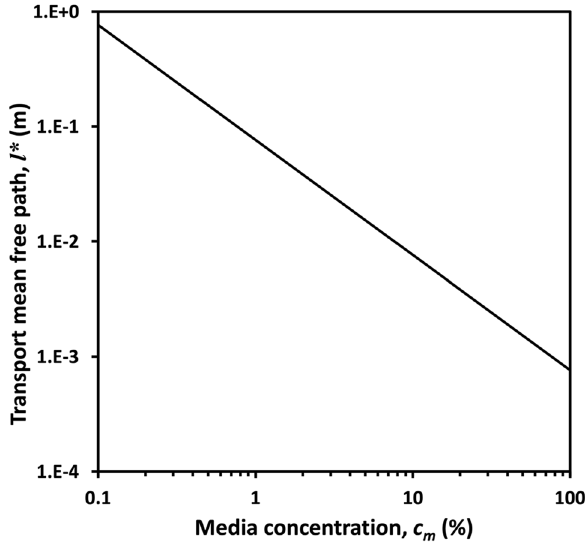
Figure 3. The variation between transport mean free path and media concentration from 0.1 to 100%.